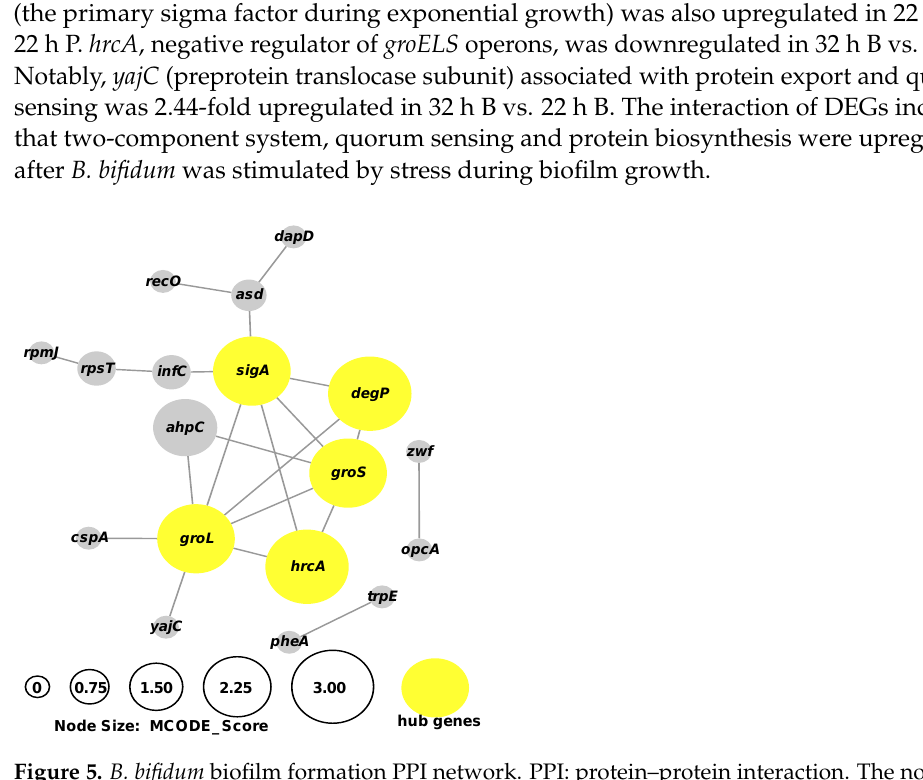
Figure 5. B. bifidum biofilm formation PPI network. PPI: protein–protein interaction. The node size was determined by MCODE degree. Yellow nodes present the hub